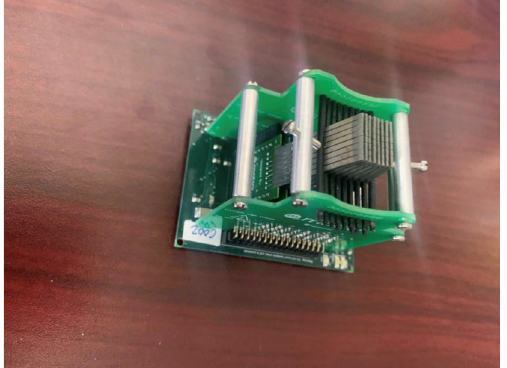
Figure 1. A photo of the Latero device without the external plastic cover. On the top of the device is an array of 8 × 8 pins, where participants place their fingertips to feel the tactile